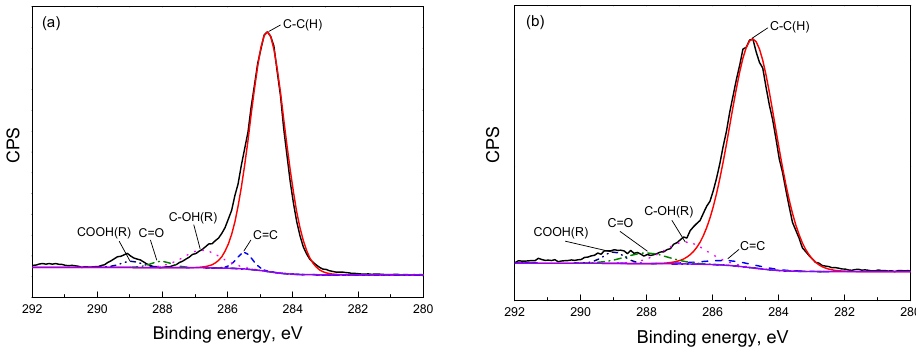
Figure 4. XPS C1s spectra of ( a ) aged SBS exposure at 150 °C for 12 h with an oxygen flowrate of 1 L/min and ( b ) aged SBS exposure at 150 °C for 48 h with an oxygen flowrate of 1 L/min. Table 3. Relative concentrations of carbon related to chemical groups at different aging times